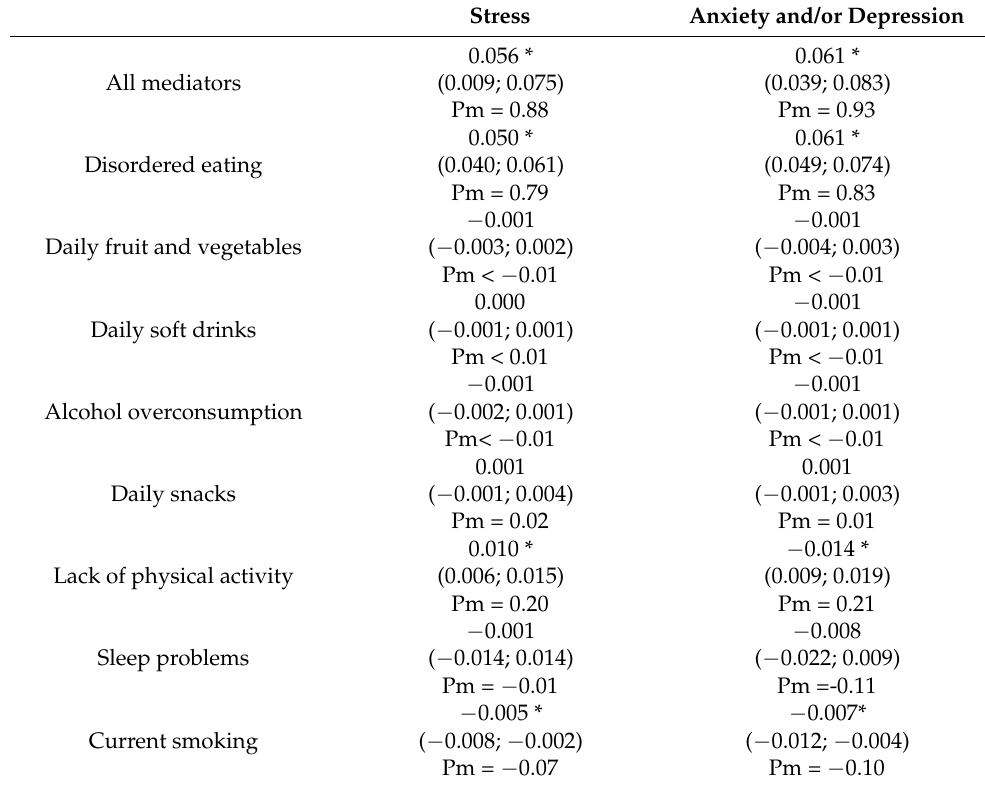
Table 3. Standardized indirect effects of lifestyle mediation in the relation between mental health (stress or anxiety and/or depression) and excess